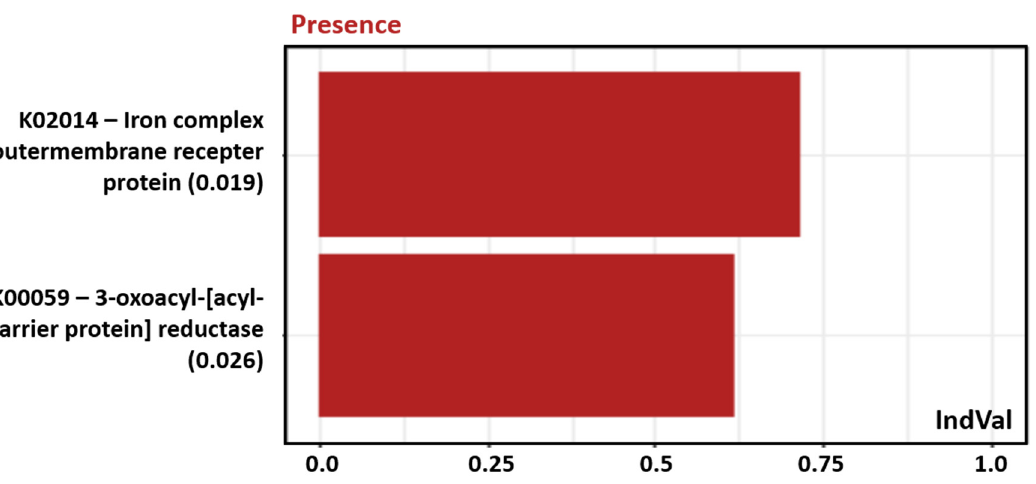
Figure 6. Indicator values of specific KO functions of provisioned sharks. Only KO functions with a frequency above 1% in at least one sample are shown; p -values in brackets.